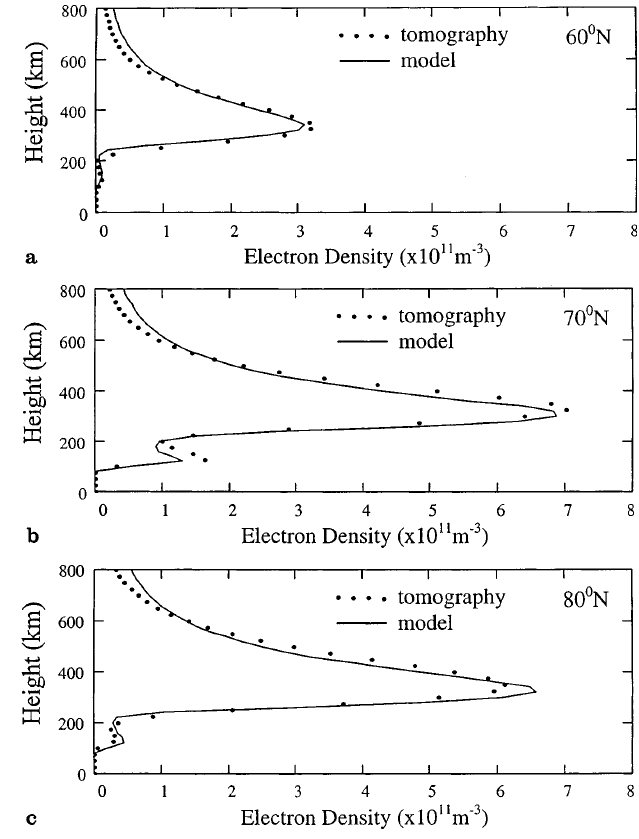
Fig. 3a–c. Comparisons of modelled ( solid ) and reconstructed ( dotted ) a vertical TEC ( (cid:180) 10 16 m ) 2 ), b ( (cid:180) 10 11 m ) 3 ) NmF2 and c hmF2 (km) values